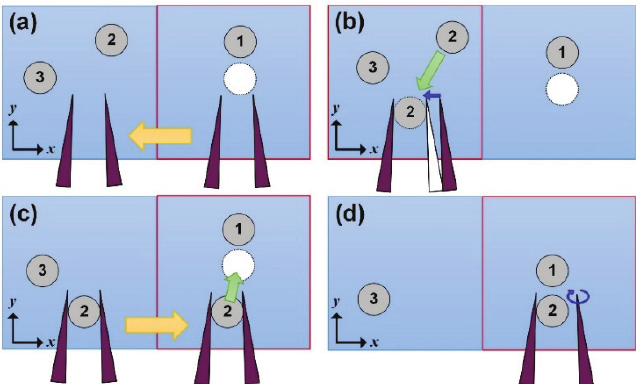
Figure 8. Manipulation of several objects outside of the visible space. ( a ) Moving the stage to find the second object; ( b ) Searching and grasping the second object; ( c ) Transporting the second object to the desired position; ( d ) Releasing the second object.